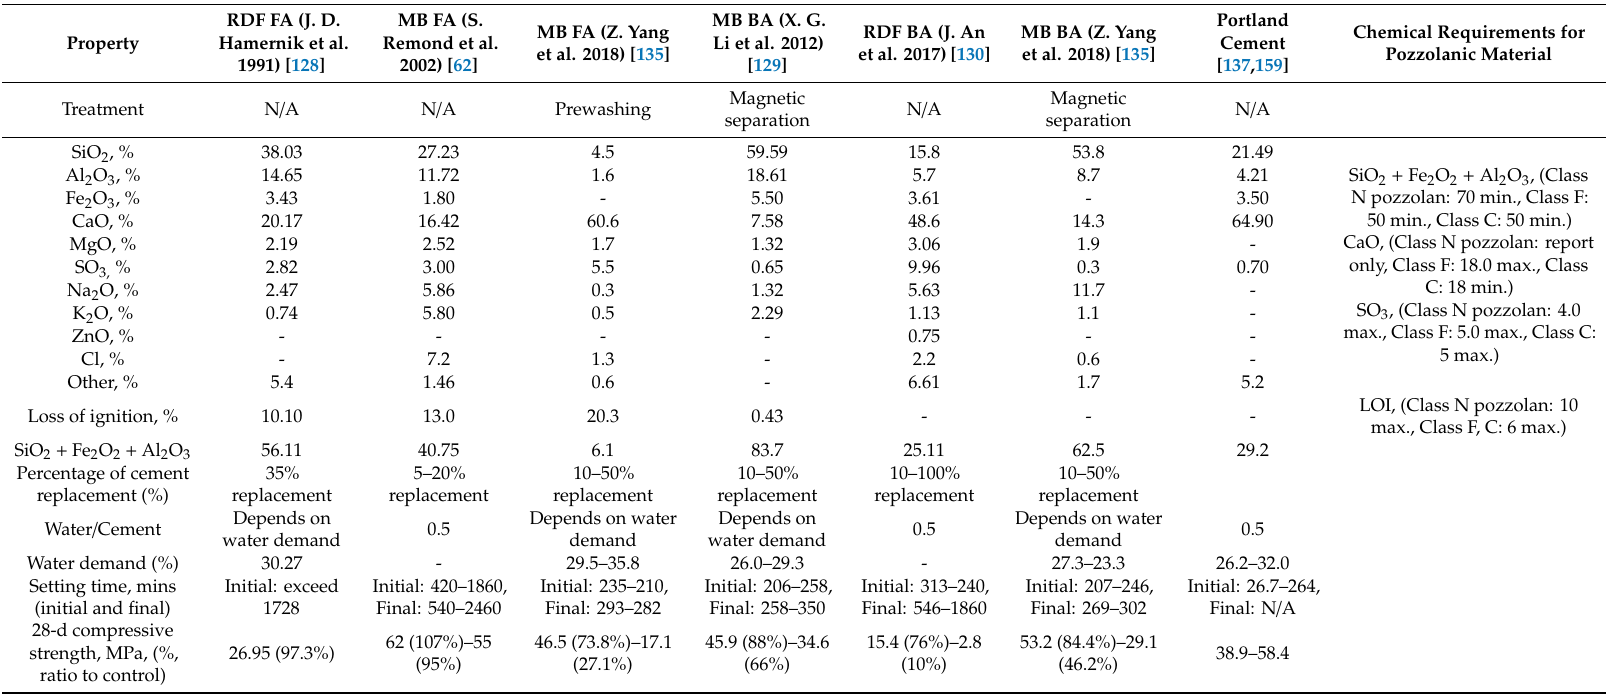
Table 4. Comparison of the chemical compositions and physical and mechanical properties between ash-blended cement and Portland cement.